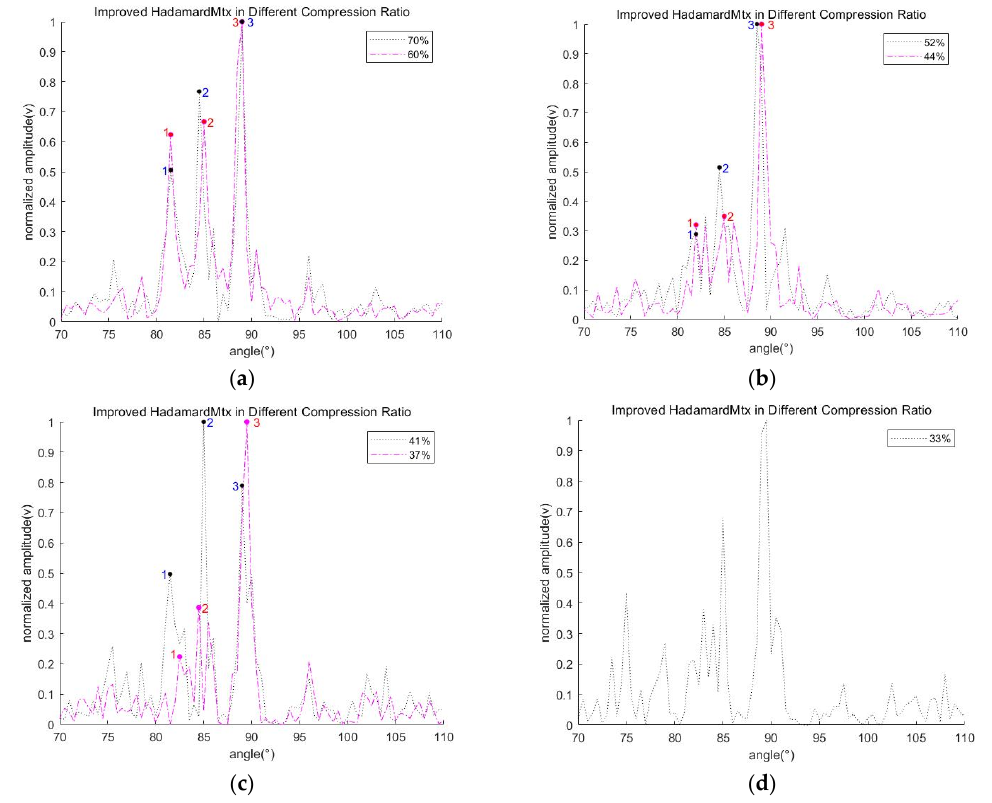
Figure 12. The reconstructed targets with improved Hadamard matrix in different compression ratio: ( a ) the reconstructed targets with improved Hadamard matrix in 70% and 60% compression ratio; ( b ) the reconstructed targets with improved Hadamard matrix in 52% and 44% compression ratio; ( c ) the reconstructed targets with improved Hadamard matrix in 41% and 37% compression ratio; and ( d ) The reconstructed targets with improved Hadamard matrix in 33% compression ratio. Table 5. The angle of a mark in different Compression Ratio.